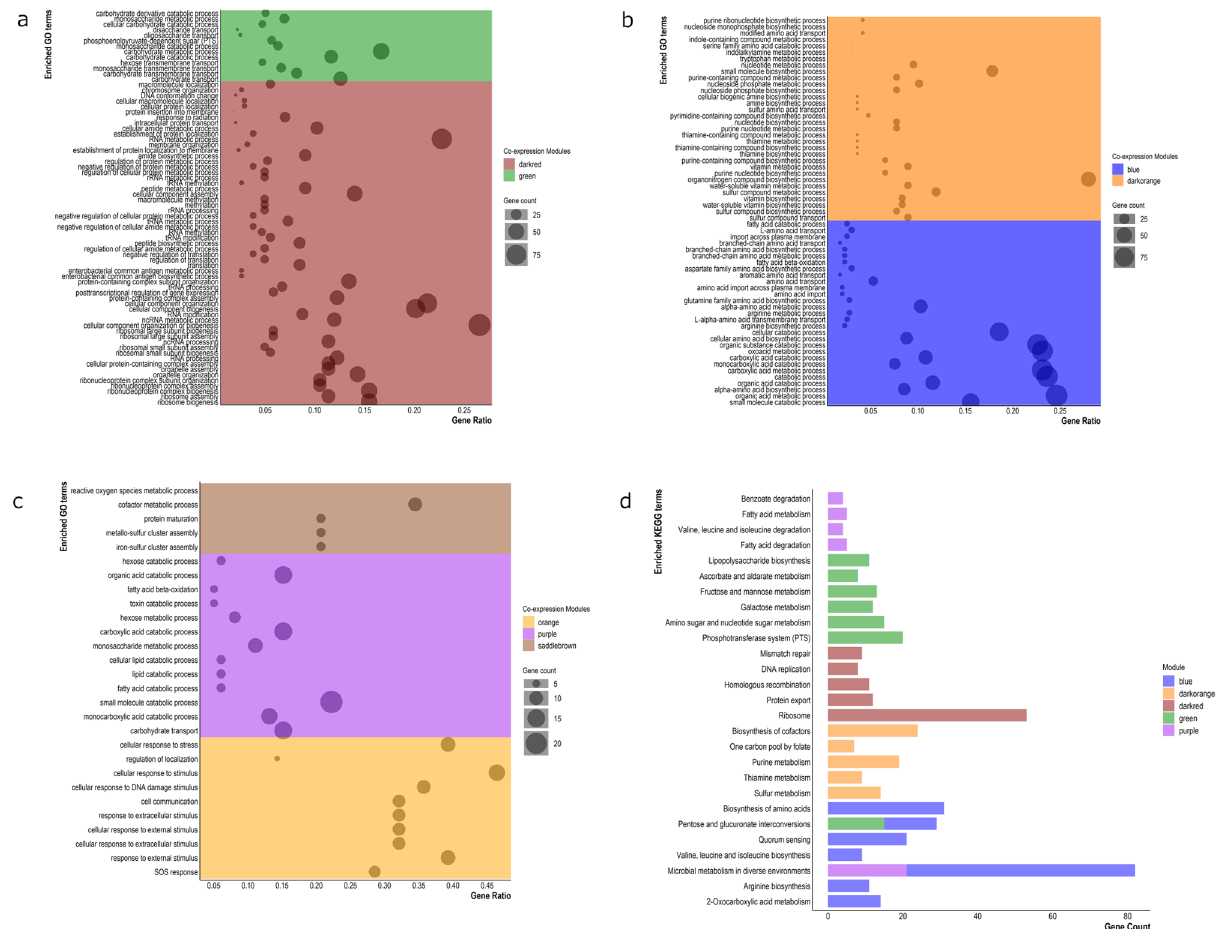
Figure 4. Functional and pathway enrichment analysis. Enriched GO-BP and KEGG terms in individual hub modules ( P adj < 0.01). The colours are representative of